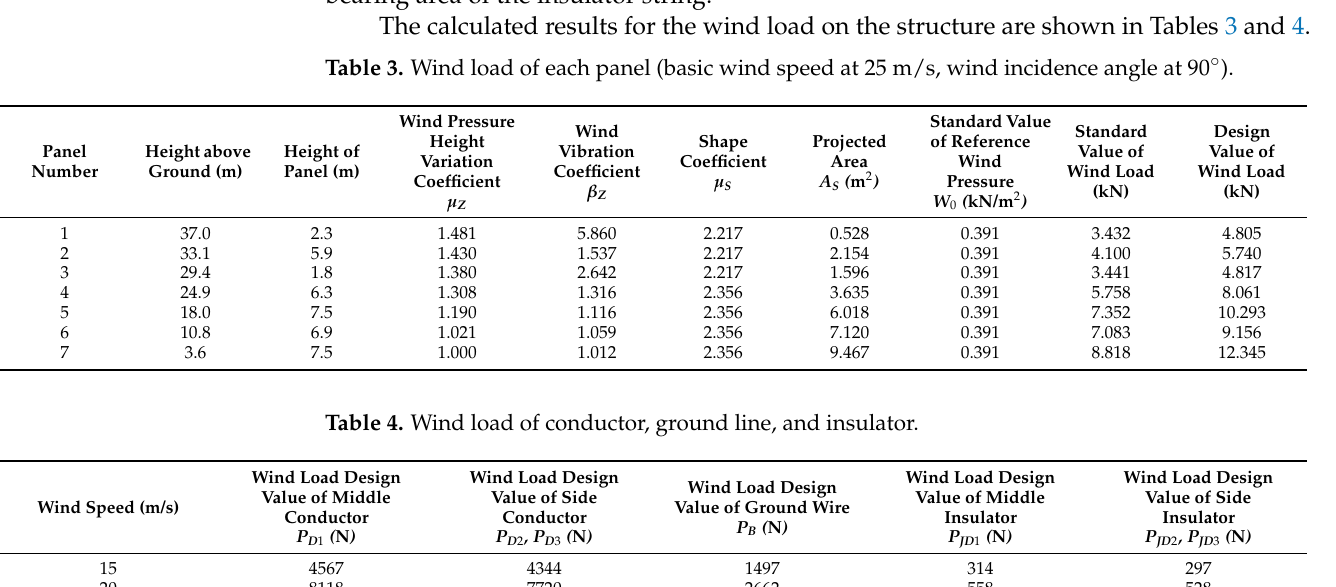
Table 3. Wind load of each panel (basic wind speed at 25 m/s, wind incidence angle at 90°).